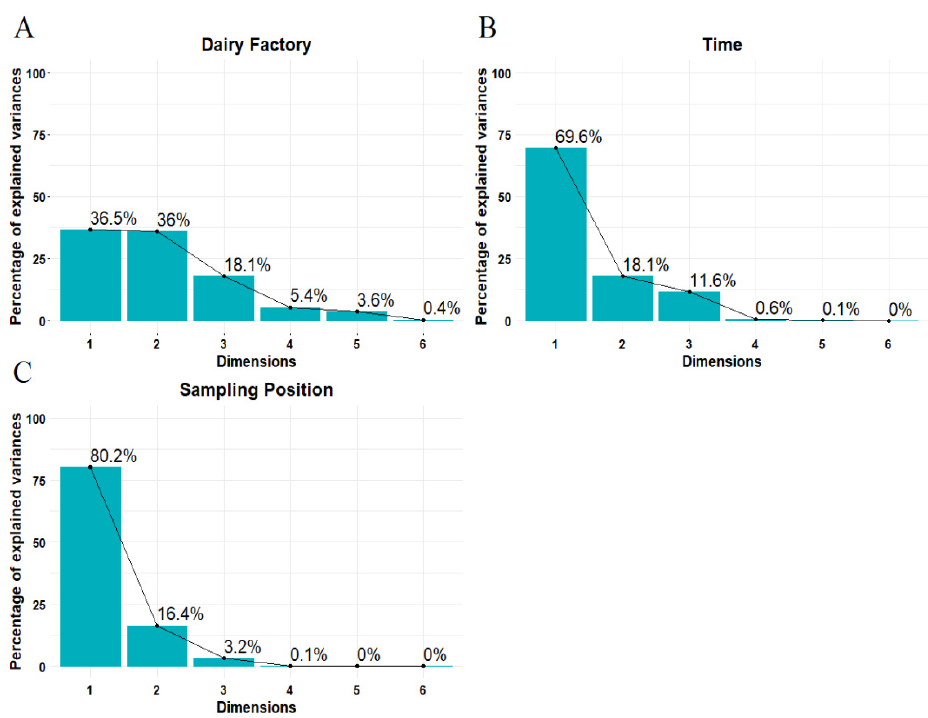
Figure 4. Scree plots for the ASCA decomposition of the factors “Dairy Factory” ( A ), “Time” ( B ), and “Sampling Position” ( C ). “Sampling Position” ( C